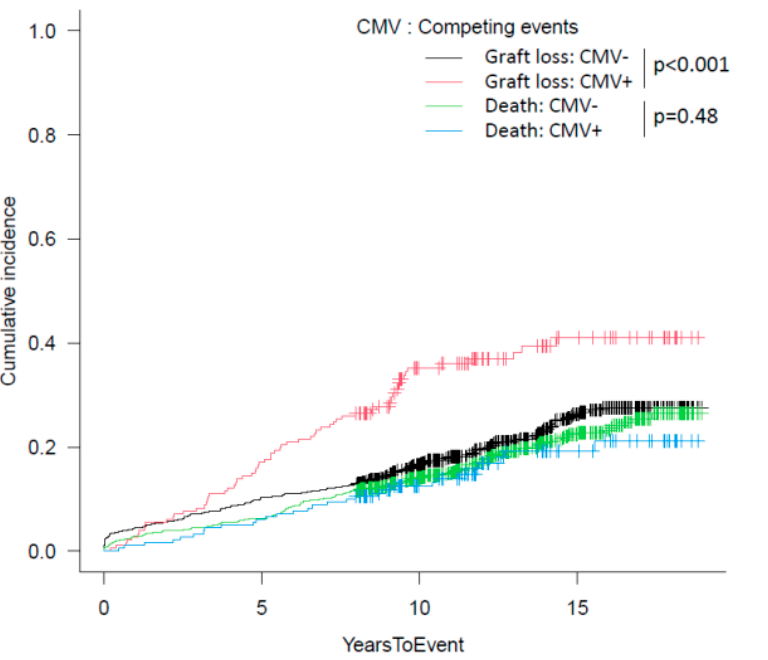
Figure 2. Cumulative incidence of graft loss, accounting for death as a competing risk, in patients with/without CMV replication/disease in the first year after transplantation.